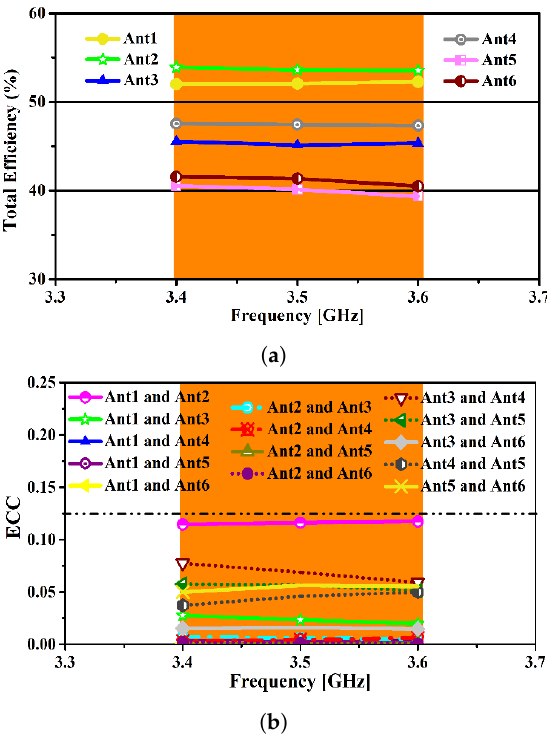
Figure 11. Single-Hand Operation (SHO) for the proposed multiple antenna system. ( a ) total efficiency. ( b ) Envelope correlation